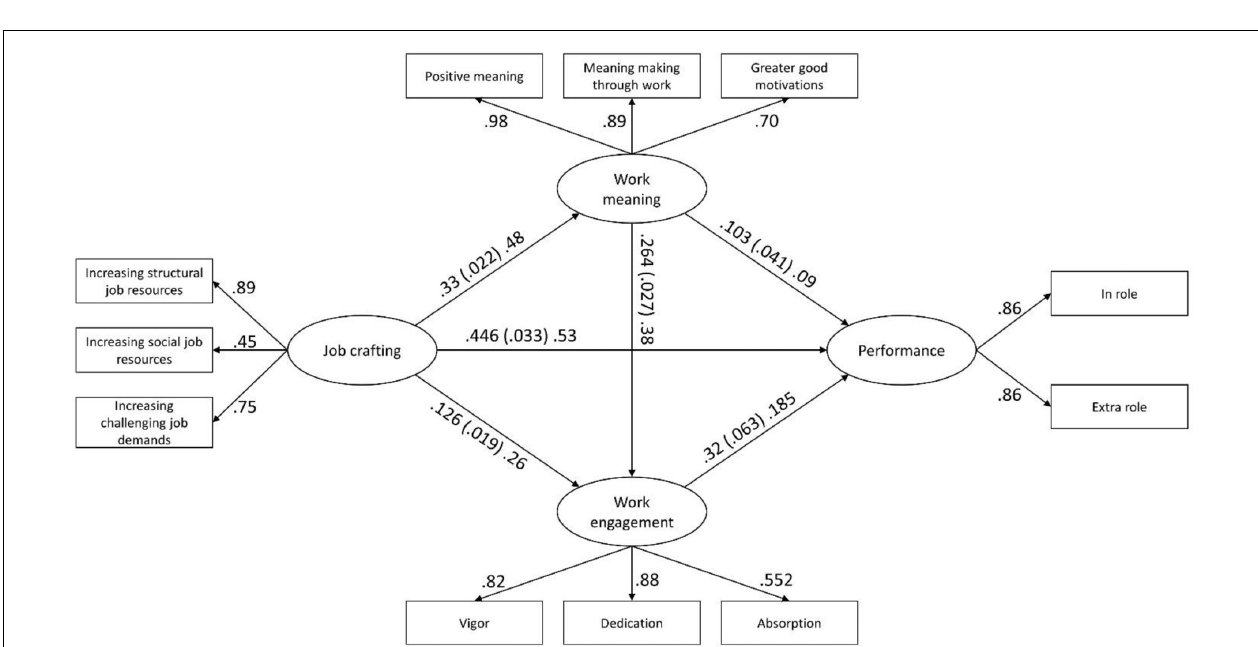
FIGURE 1 | Hypothesized relationships of the proposed research model. All predicted relationships are positive.